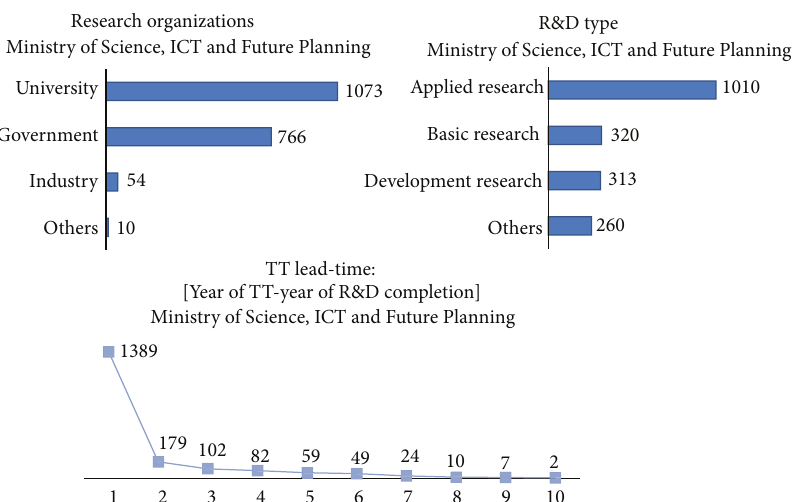
Figure 4: The outcomes of the technology transfer by the science and technology related ministry of the national R&D projects.